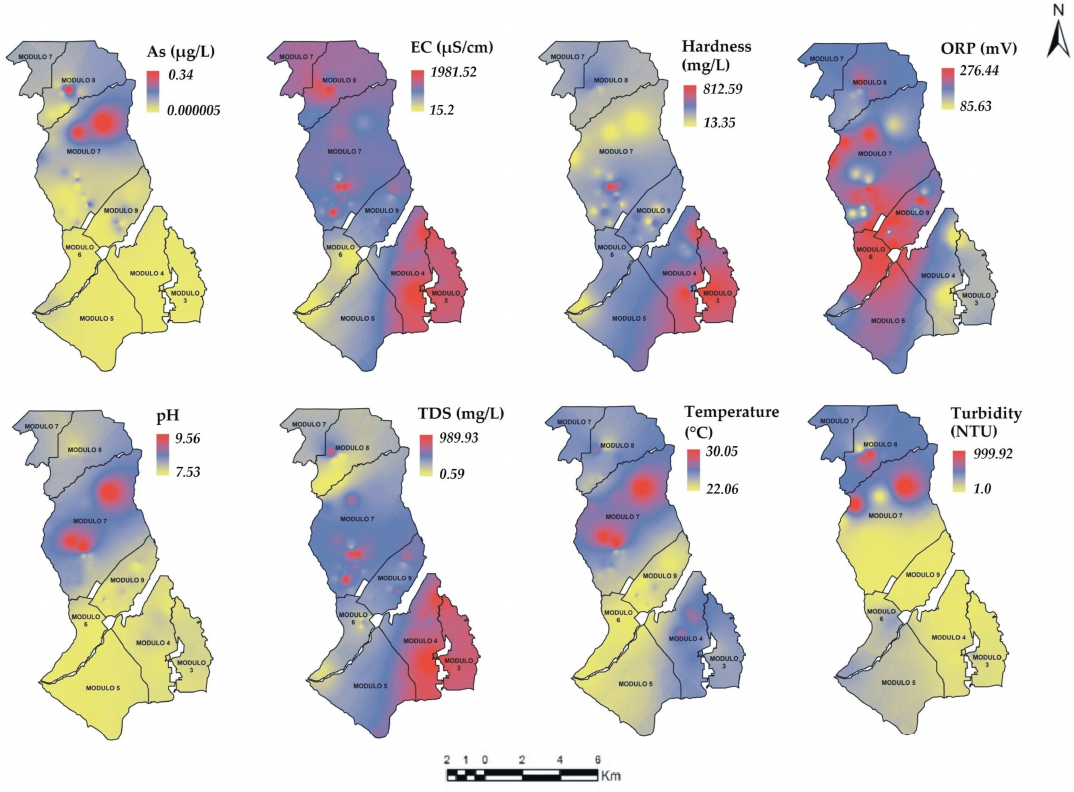
Figure 6. Spatial distribution of the PhP in the ID005 for S1. As = Arsenic, EC = Electrical Conductivity, pH = pH, ORP = Oxide Reduction Potential, studied modules (—).